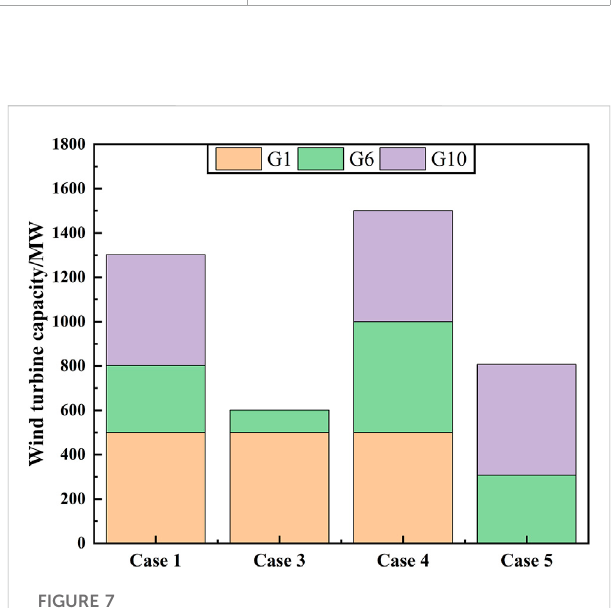
FIGURE 7 Wind turbine capacity planned in Case1, Case3, Case4, and Case5.